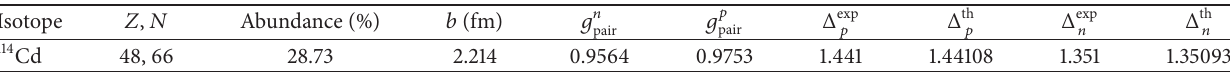
Table 1: Parameters determining the BCS ground state pairing interactions for protons ( 𝑔 𝑝 values of proton ( Δ th 𝑝 ) and neutron ( Δ th 𝑛 ) energy gaps. The latter reproduce well the corresponding (for 114 Cd isotope) empirical energy gaps, Δ exp 𝑝,𝑛 , listed also in the table, obtained through the three-point formula [6]. The values of the harmonic oscillator size parameter 114 Cd isotope, are also